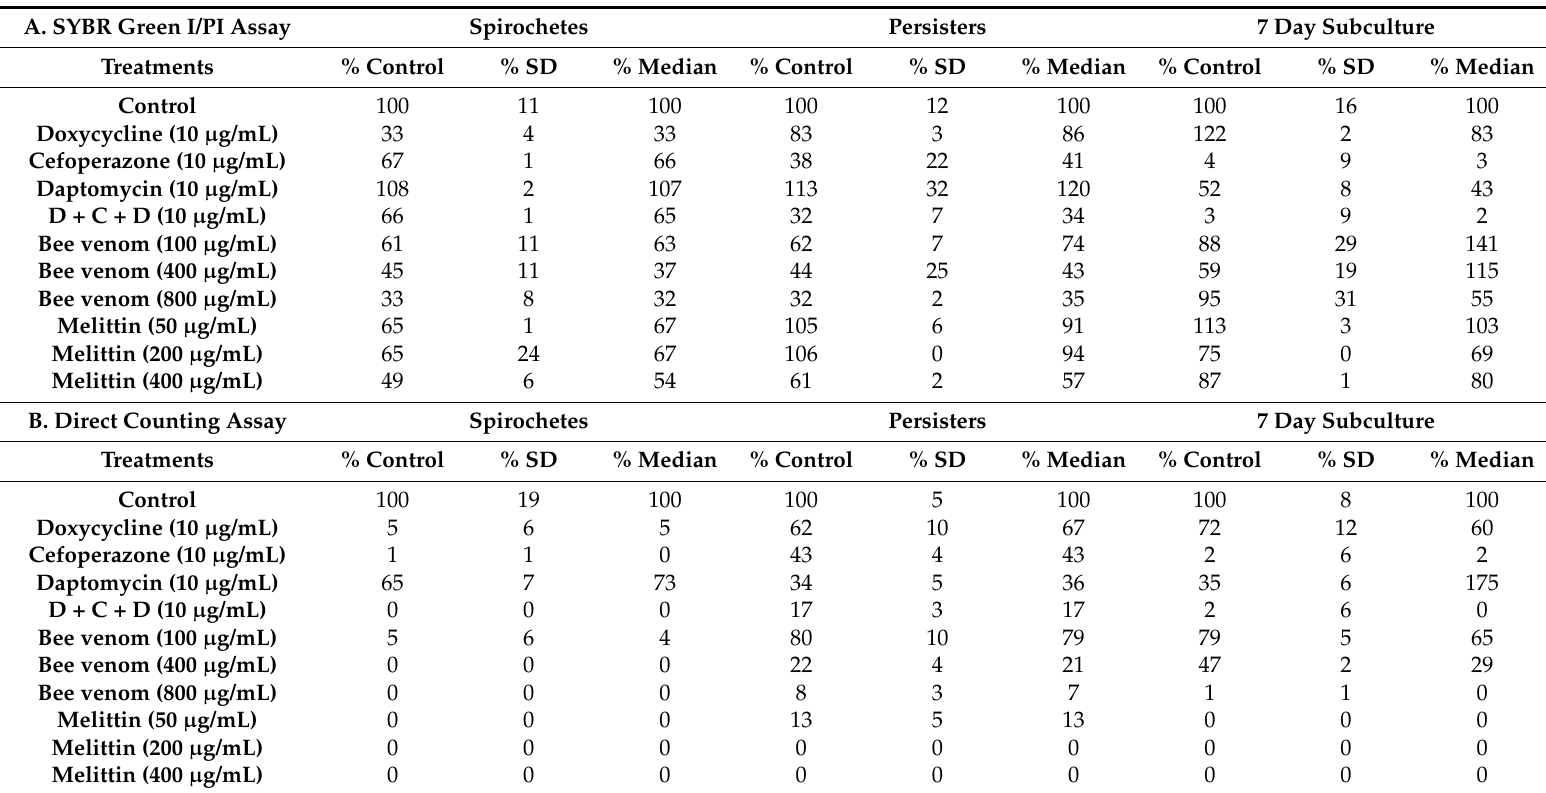
Table 1. The effects of various antimicrobial agents on B. burgdorferi as determined by SYBR Green I/PI assay (Panel (A)) or direct counting assay (Panel (B)). Doxycycline, Cefoperazone, Daptomycin and their combination (D + C + D) as well as different concentration of bee venom and melittin were tested on B. burgdorferi logarithmic phase (spirochetes) culture and stationary phase (persisters) cultures as well as in 7-day recovery subculture as described previously [6–8,26]. n =